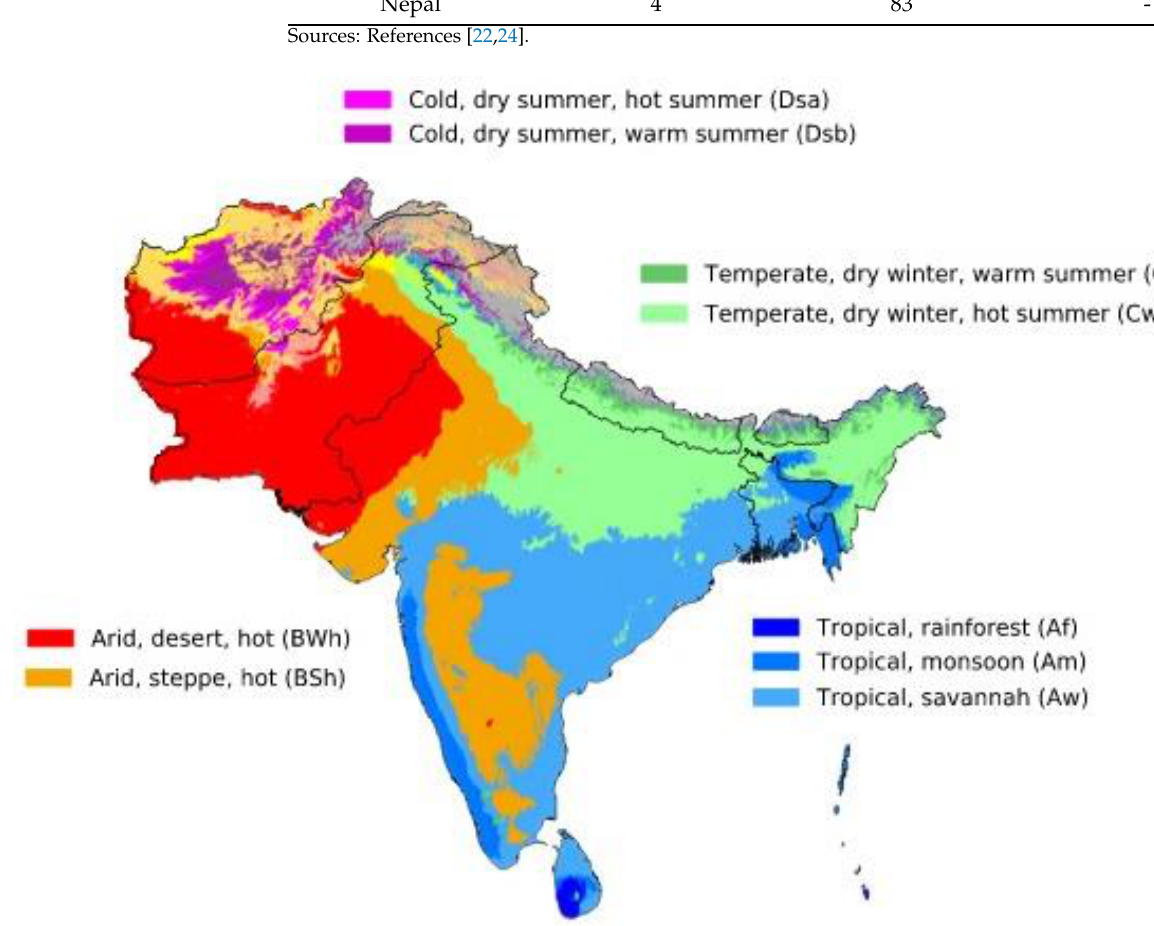
Figure 1. The climate of South Asia. Source: Reference [1].